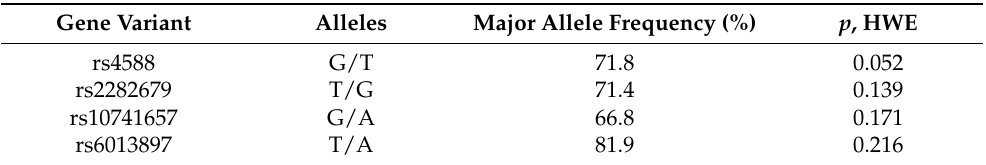
Table 3. The Hardy–Weinberg equilibrium p -values and distribution of genotype frequencies of selected variants.